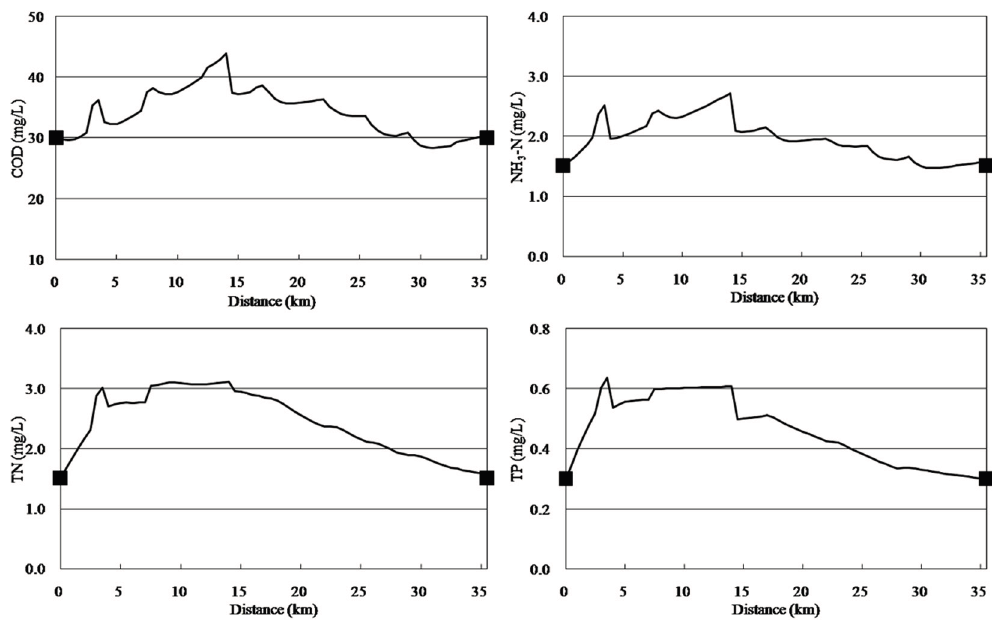
Figure 8. Simulation curves from implementing the river control measures.